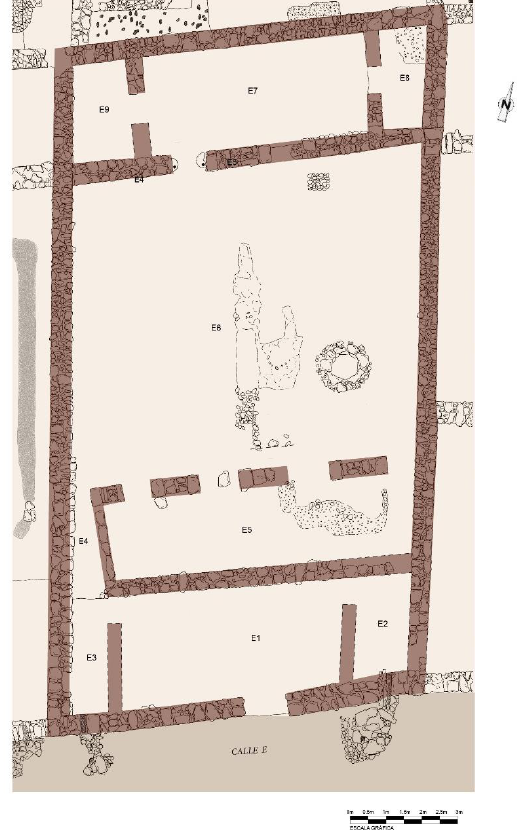
Figure 23. Variant 5. House 128. Plan and room distribution.